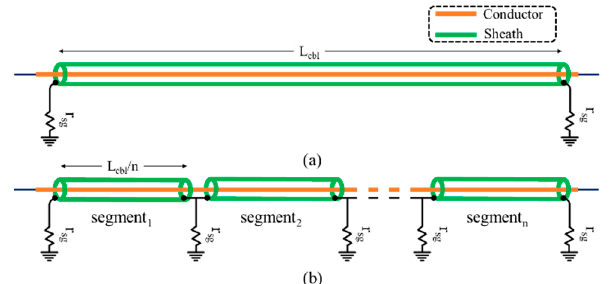
Figure 3. Schematic of a cable with ( a ) sheath grounded at terminals: terminal grounded (TG). ( b ) sheath grounded at multiple equally spaced locations along the length: multipoint grounded (MG).